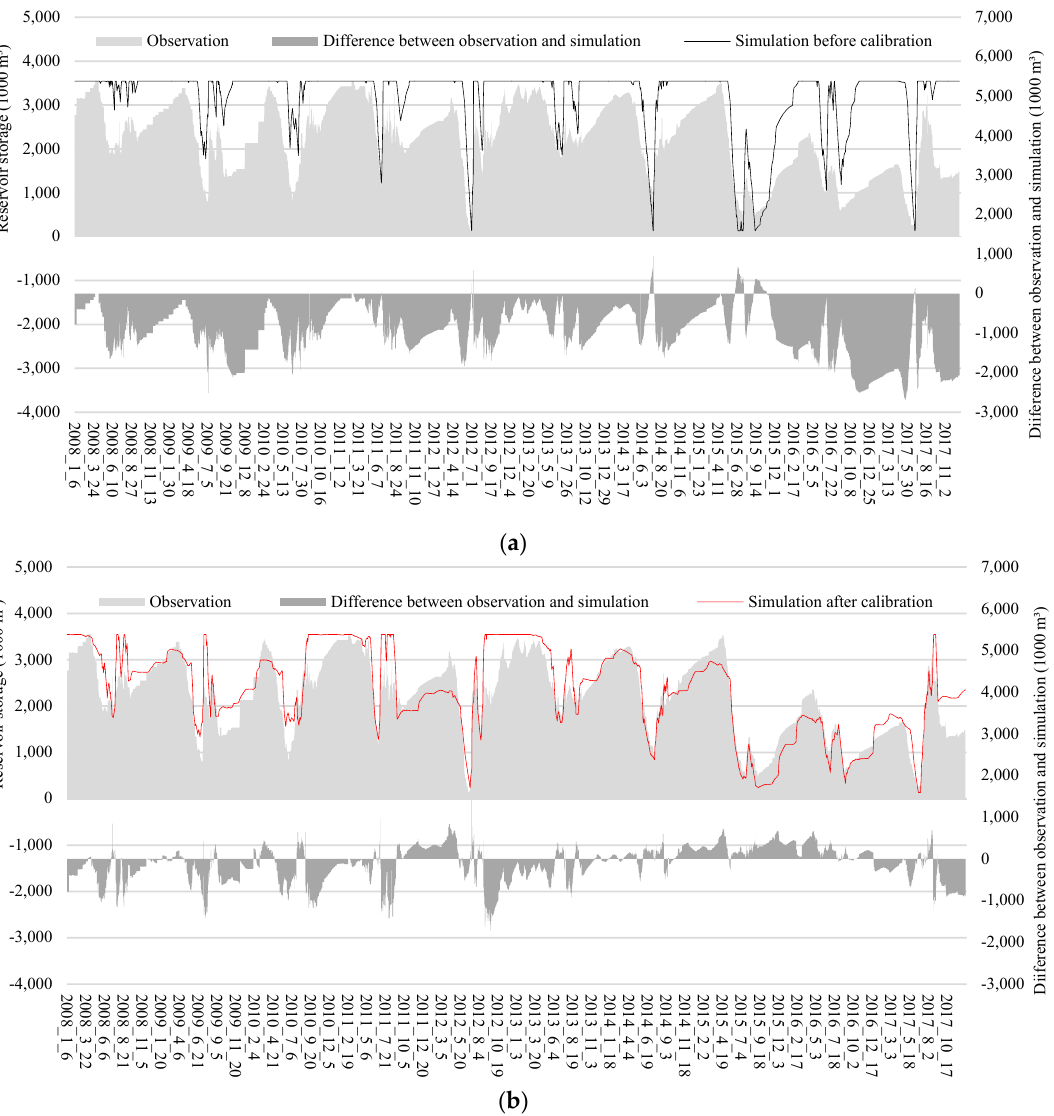
Figure 5. Simulation of water storage capacity of Deokwoo reservoir before and after calibration using RCFs. ( a ) Before calibration (Deokwoo reservoir); ( b ) after calibration (Deokwoo reservoir).